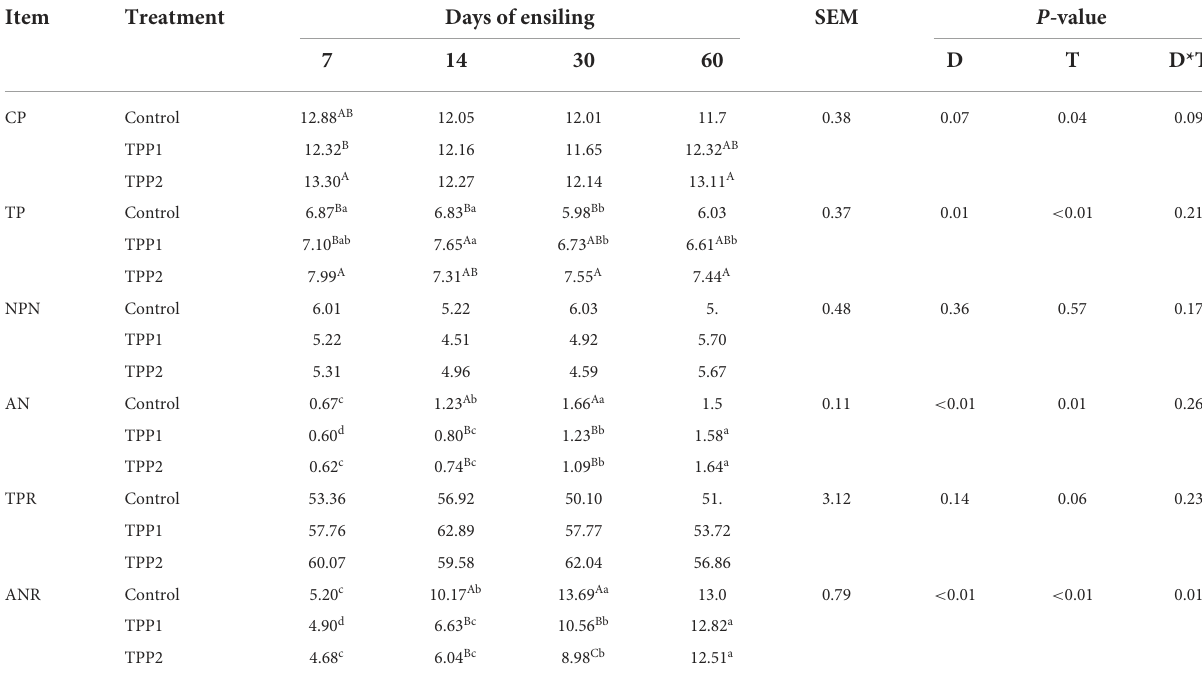
TABLE 3 Effect of tea polyphenols on the dynamic protein fraction of stylo silage.